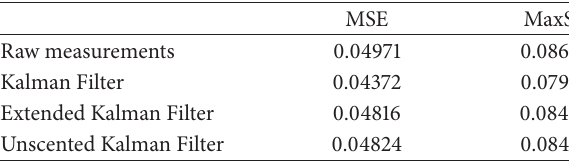
Table 3: Oval path results (1 tag).